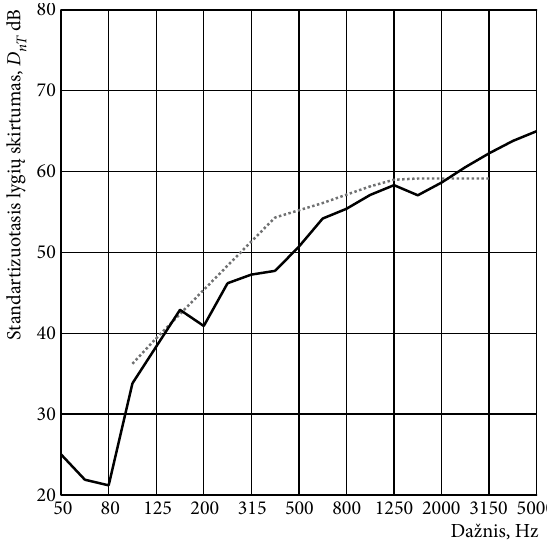
rodiklio atskaitos 55 dB kreivės atžvilgiu (taškinė 8 pav. D nT kreivė) priklausomybė nuo keramzitbetonio blokelių mūro konstrukcijos dažnio (7 pav.) indicator with Fig. 8. The correlation of readings of D nT respect to curve 55 dB (dotted curve) with frequency for wall construction from expanded-clay concrete blocks (see Fig.